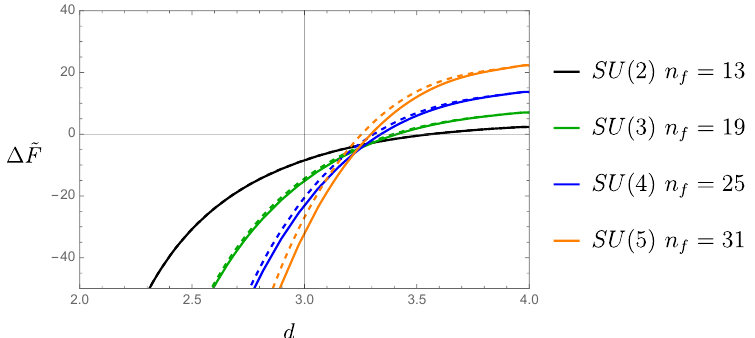
Figure 2 . Values of ∆ e F for SU( n c ) as a function of the dimension d computed with Padé- approximants [2/1] (continuous line) and [1/2] (dashed line) at n is set to the smallest integer without poles in both approximants in 2 < d < 4 satisfying g ∗ 2 > 0